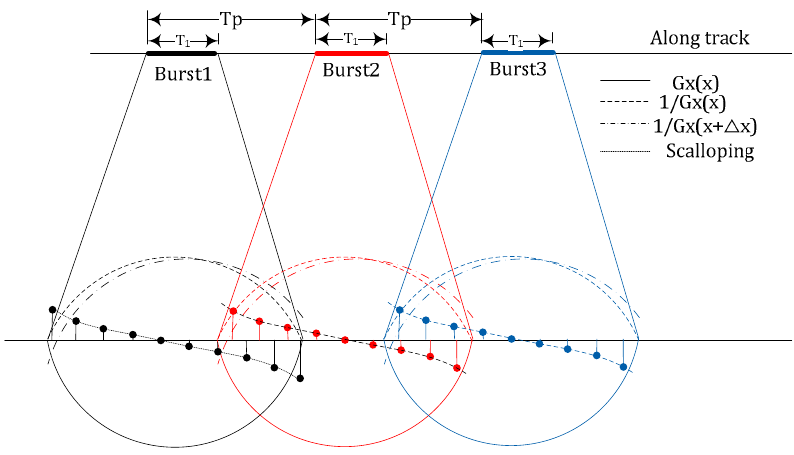
Figure 3. ScanSAR azimuth antenna pattern correction and scalloping schematic diagram.